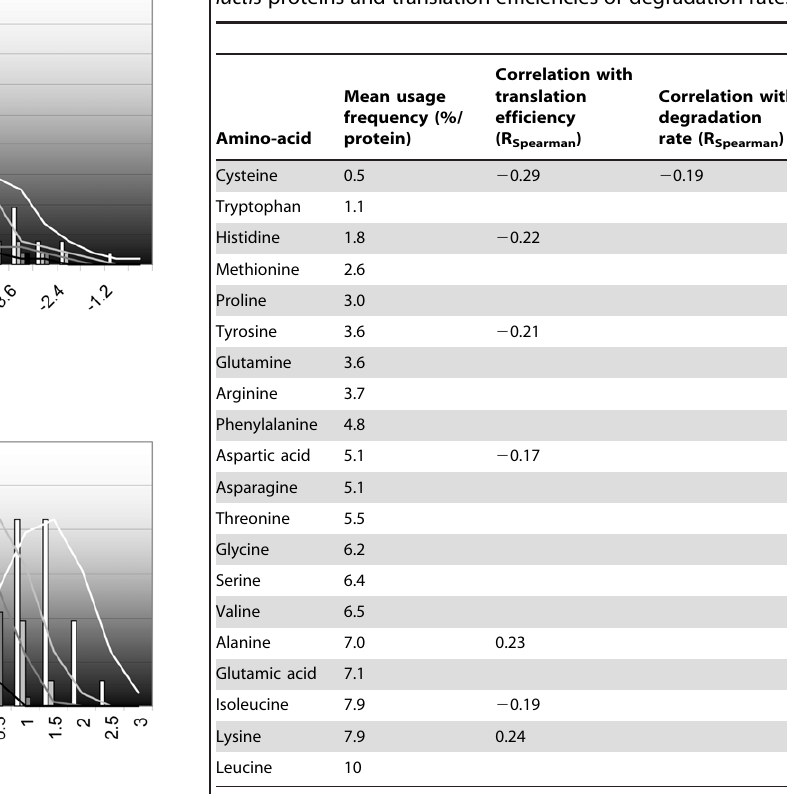
Table 4. Correlation analysis between amino-acid usage in L. lactis proteins and translation efficiencies or degradation rates.